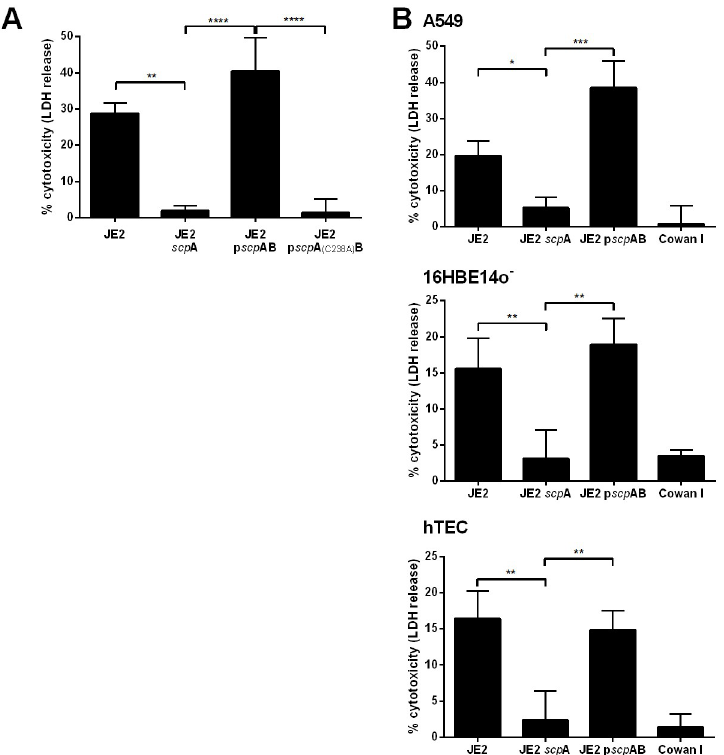
Fig 2. Loss of staphopain A reduces intracellular cytotoxicity of S . aureus in different epithelial cell lines and primary cells. (A) HeLa cells were infected with wild type strain (JE2), staphopain A mutant (JE2 scp A), complemented mutant (JE2 p scp AB) or complemented mutant with active site mutated ScpA (JE2 scp A (C238A) B) and LDH release was measured 6 h p.i. (B) Further epithelial cell lines/cells such as A549, 16HBE14o - and human primary tracheal epithelial cells (hTEC) were infected with JE2 wild type, staphopain A mutant (JE2 scp A) or complemented mutant (JE2 p scp AB) and cell death was assessed at 6 (A549, 16HBE14o - ) or 8 h p.i. (hTEC) by LDH assay. Statistical significance was determined by one-way ANOVA ( � P < 0.05, �� P < 0.01, ��� P < 0.001, ���� P <